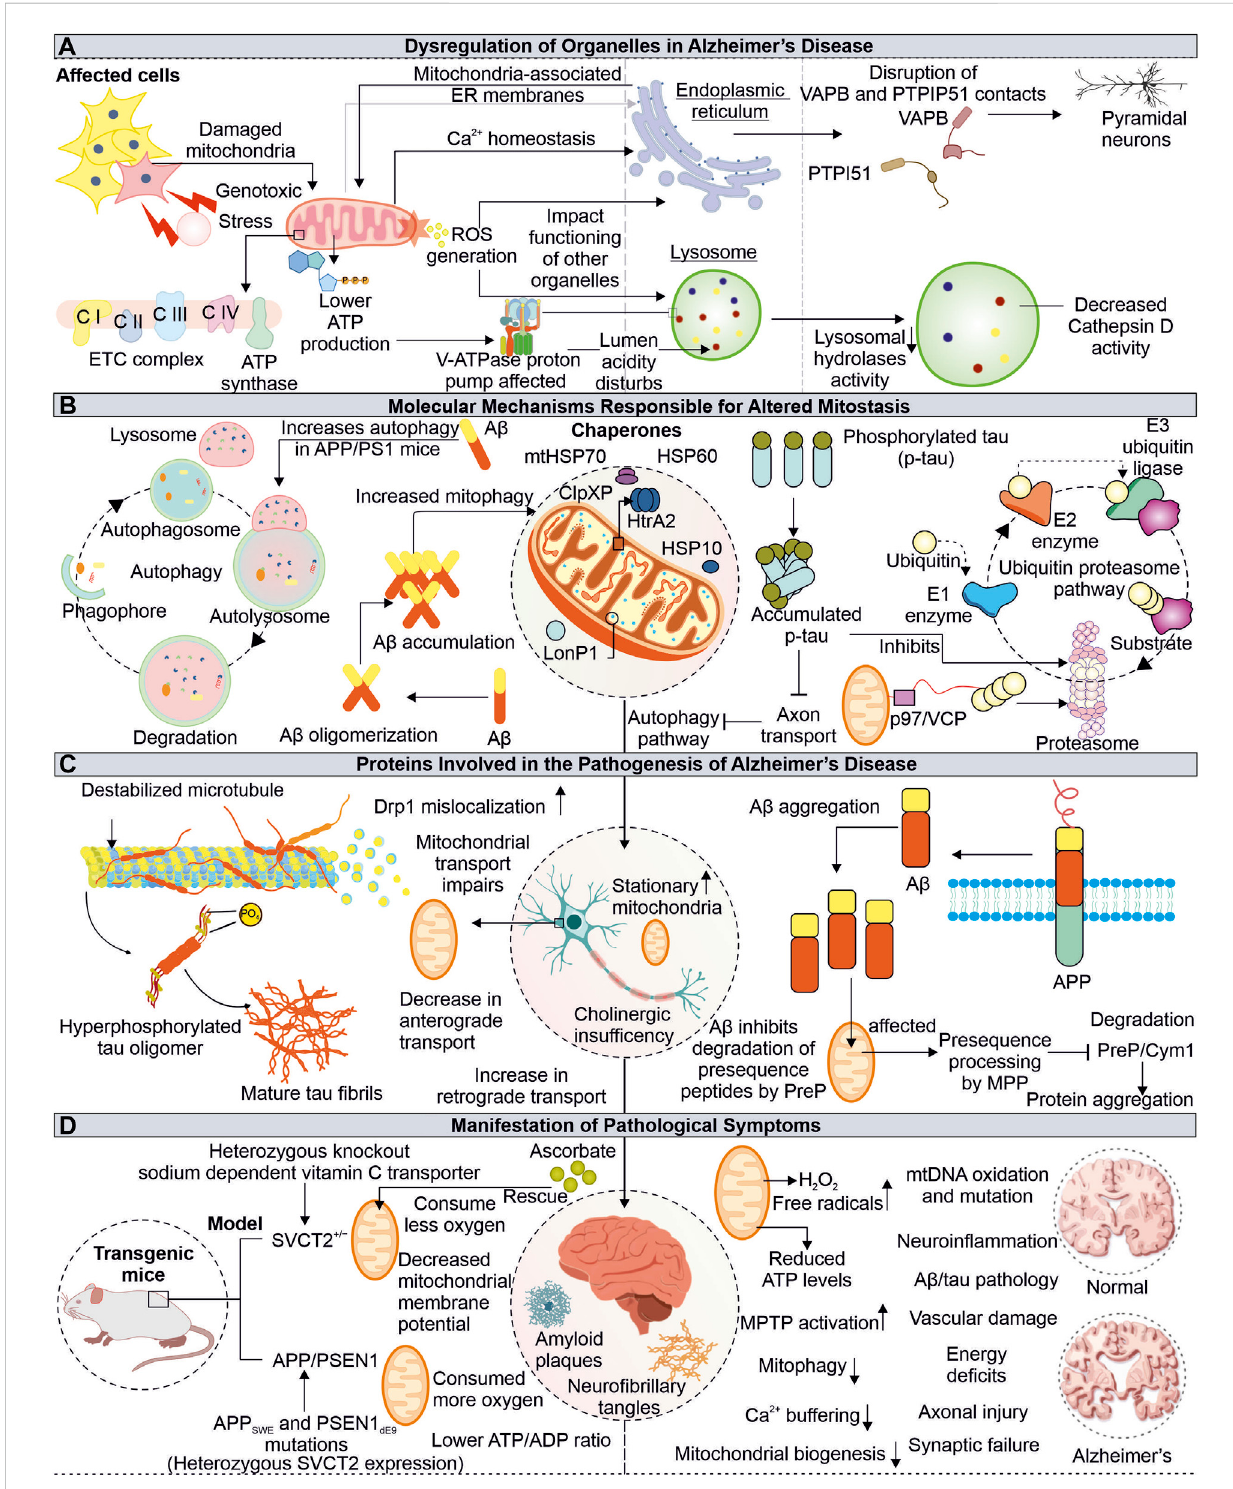
FIGURE 3 Impaired functions of Mitochondria in Alzheimer ’ s disease. Mitochondrial dysfunction due to pathogenic proteins from AD depletes the cellular energy, further affecting other organelles such as ER and lysosome (A) . The pathogenic A β and tau proteins are also identi fi ed to impair cellular quality control pathways, including autophagy and proteasome (B) . The tau and A β alter the normal mitochondrial functions and axonal transport (C) . The AD- associated physiological changes are linked with mitochondrial damage, where the misfolded A β and tau affect mitochondrial function at different levels (D)